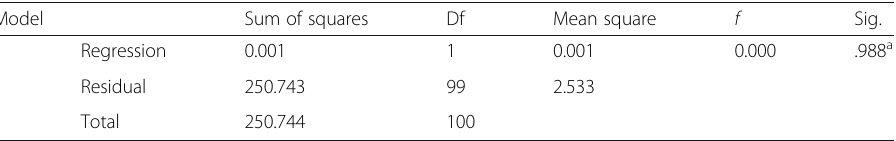
Table 17 ANOVA Model Sum of squares